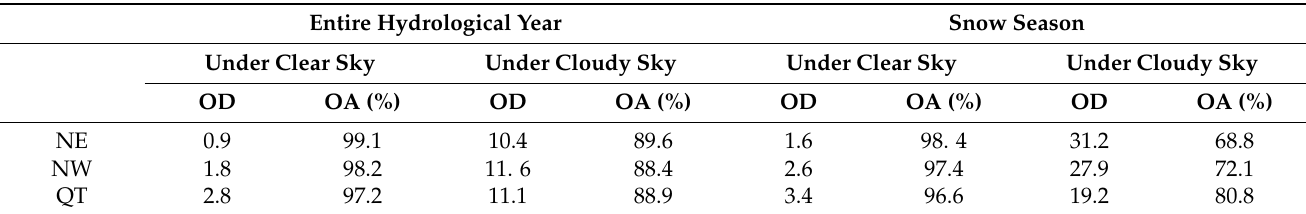
Table 2. The OD and OA of snow cover under clear and cloudy sky conditions. Entire Hydrological Year Snow Season Under Clear Sky Under Clear